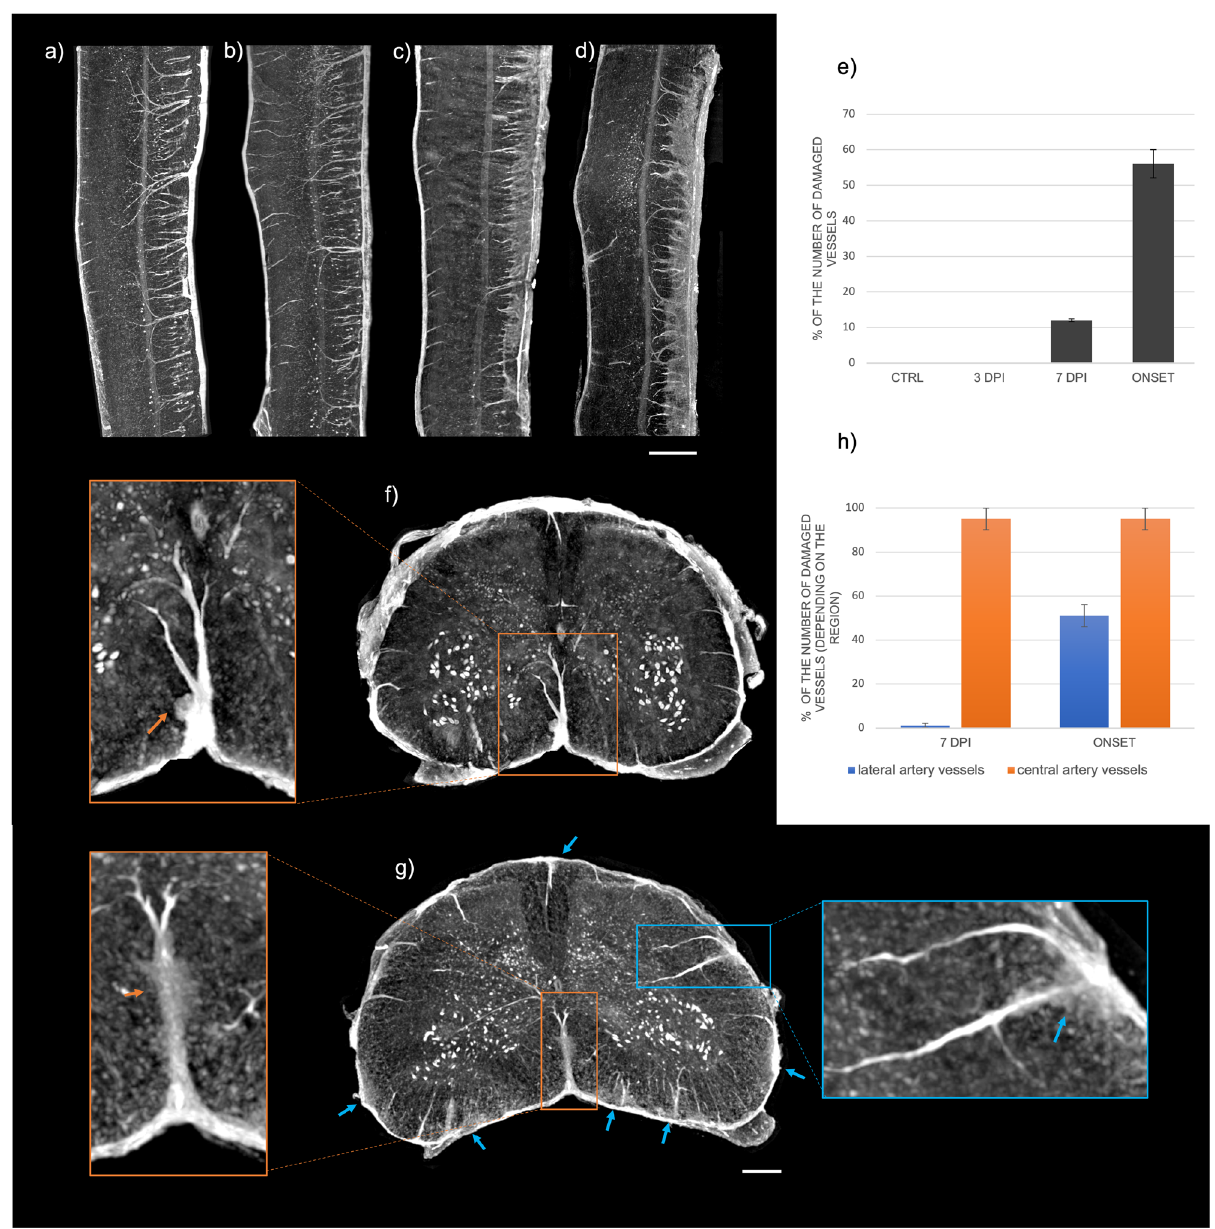
Fig. 1 Blood-spinal cord barrier leakage and lesion in lumbar spinal cord. The images show X-ray phase contrast tomography (XPCT) imaging and quanti fi cation of blood-spinal cord barrier leakage and lesion in lumbar spinal cord of experimental autoimmune encephalomyelitis (EAE)-induced mice. a – d XPCT images showing the sagittal views of the lumbar spinal cord in a naïve mouse ( a ) and in EAE-induced mice at 3 days post induction (dpi) ( b ), 7 dpi ( c ), and disease onset ( d ). In ( c ) and ( d ) the vessels arising from the anterior spinal artery appear surrounded by numerous clouds of extravasated material re fl ecting the intense blood-spinal cord barrier dysfunction in the EAE-induced mice. Scale bar = 500 μ m. e Quanti fi cation of the number of damaged vessels with respect to the total number of vessels in lumbar spinal cord samples of EAE-induced mice ( n = 3 per group). The data are presented as mean ± SEM. f , g XPCT images showing the axial view of lumbar spinal cord of EAE-induced mice at 7 dpi ( f ) and onset ( g ). The insets and the arrows highlight the presence and the localization of clouds. At 7 dpi ( f ), vascular degeneration appears to involve vessels arising from the anterior spinal artery (inset). In contrast, at onset ( g ) the lesion becomes more extensive, involving also vessels arising from minor arteries (arrows and blue inset). Scale bar = 200 μ m. h Quanti fi cation of the number of damaged vessels over the total number of vessels, separately for vessels originating from the central artery (orange) and for vessels originating from secondary arteries and venules (blue), in lumbar spinal cord samples from EAE-induced mice at 7dpi and onset ( n = 3 per group). The data are presented as mean ± SEM. Clinical EAE score at the onset = 3. Images a – d , f , g were obtained as maximum intensity projections of XPCT volumes ( a – d over 150 μ m; f , g over 100 μ m). XPCT images were acquired in Experiment 1, reported in